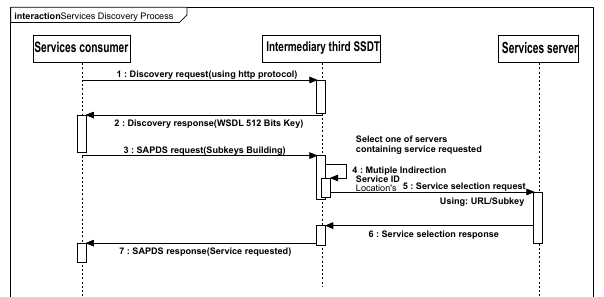
Figure 8. Service Secured Discovery.